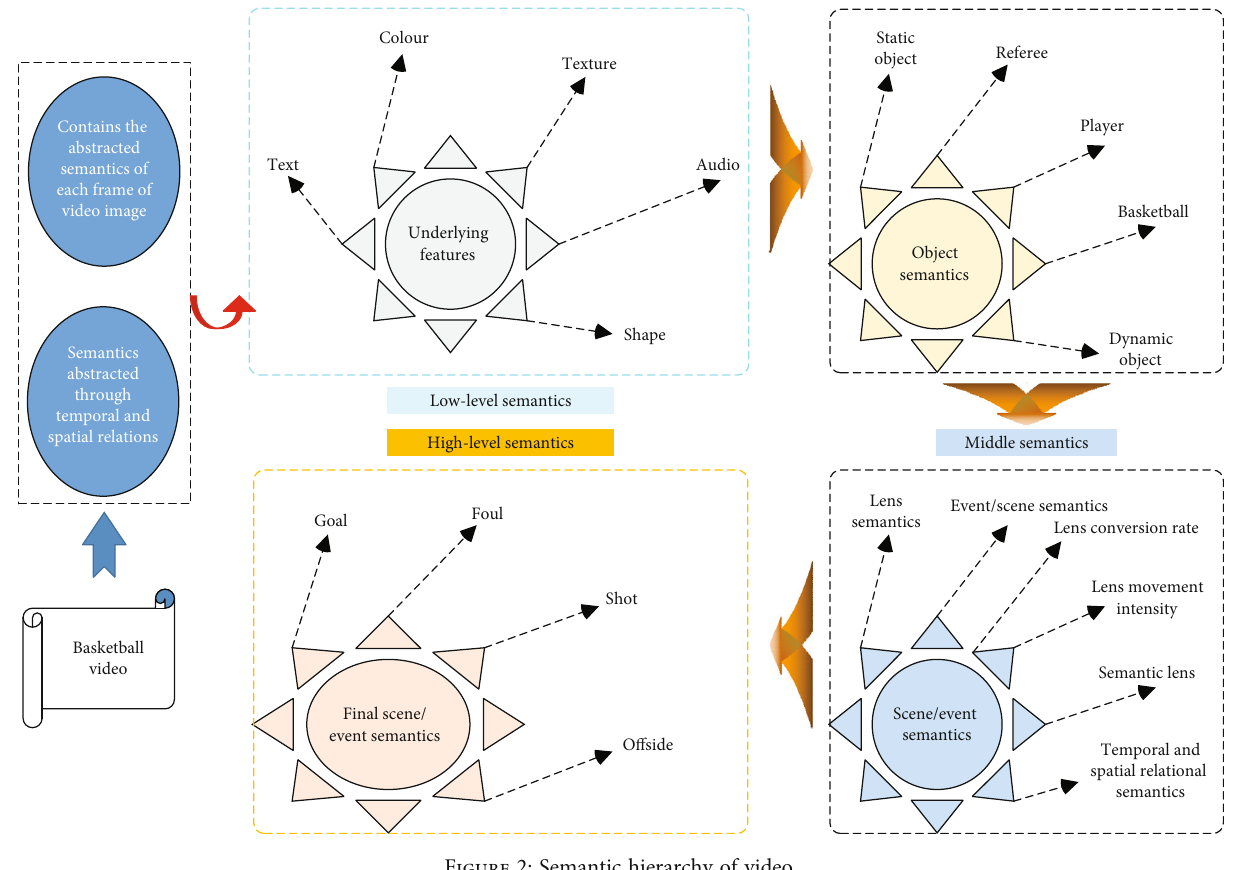
Figure 2: Semantic hierarchy of video.